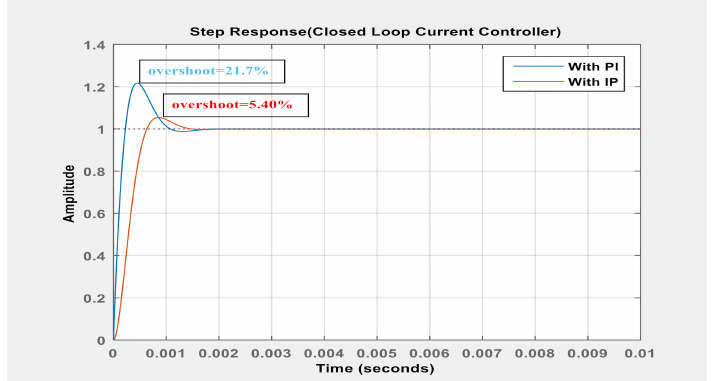
Figure 18. Step response of the inner current control loop with different controllers.